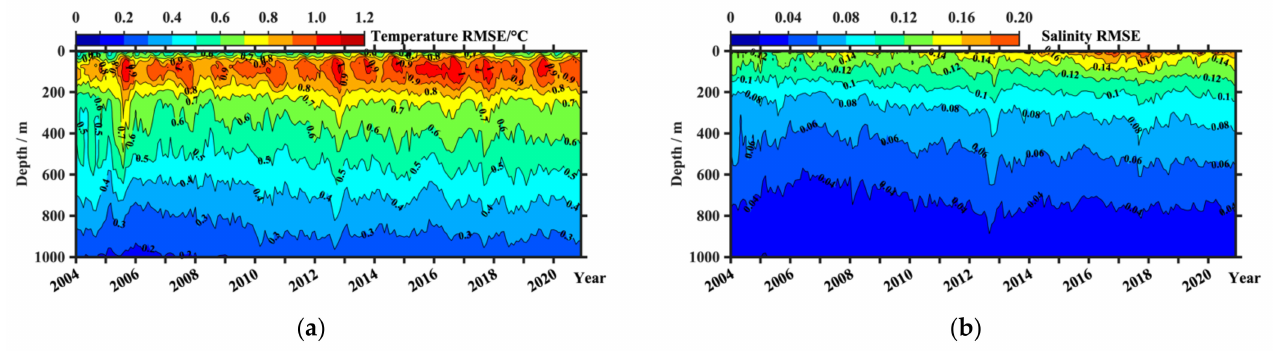
Figure 5. Time series for RMSEs of ( a ) temperature and ( b ) salinity of gridded data from GDCSM- Argo compared with merged observations at a depth above 1000 m. The data are from January